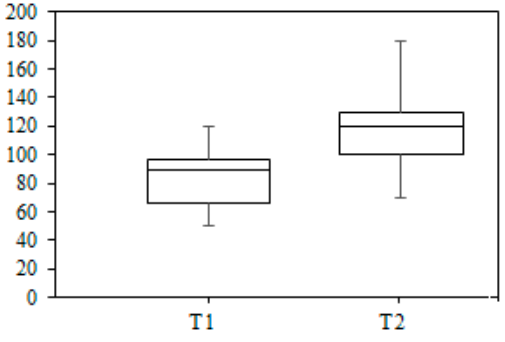
Figure 12. Boxplot for total time taken by two teams to execute the RE task.